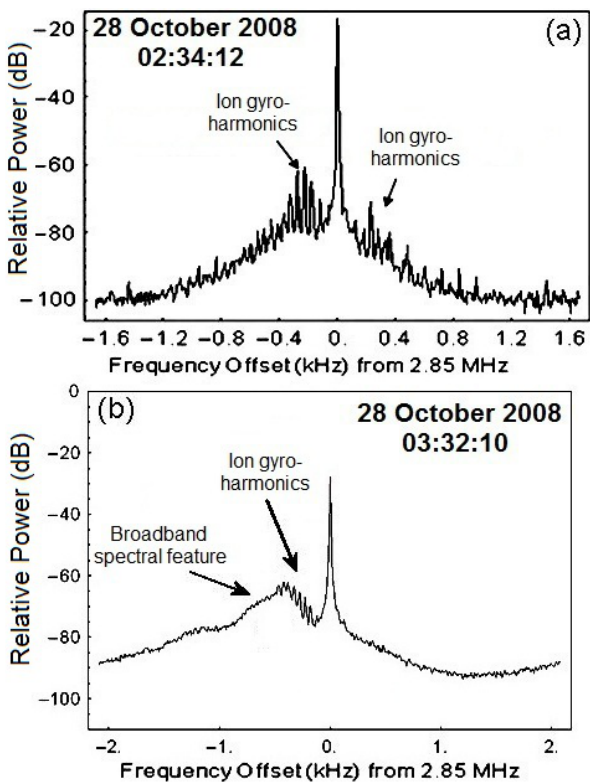
Fig. 1. Experimental observations of (a) ion gyro-harmonic struc- tures and (b) simultaneous broadband and ion gyro-structures ob- served at HAARP during which heater frequency was tuned close to second electron gyro-harmonic